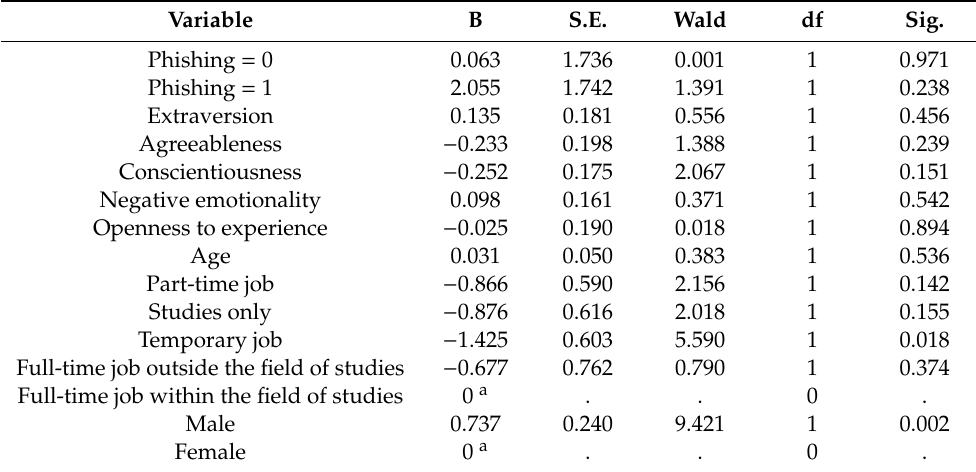
Table 5. Full Model 3—Phishing: ordinal logistic regression.